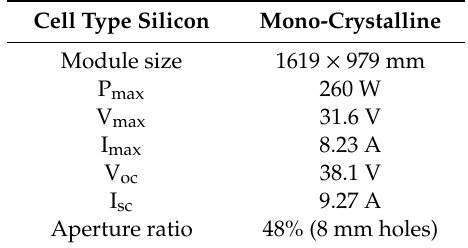
Table 1. Specifications of the photovoltaic (PV)